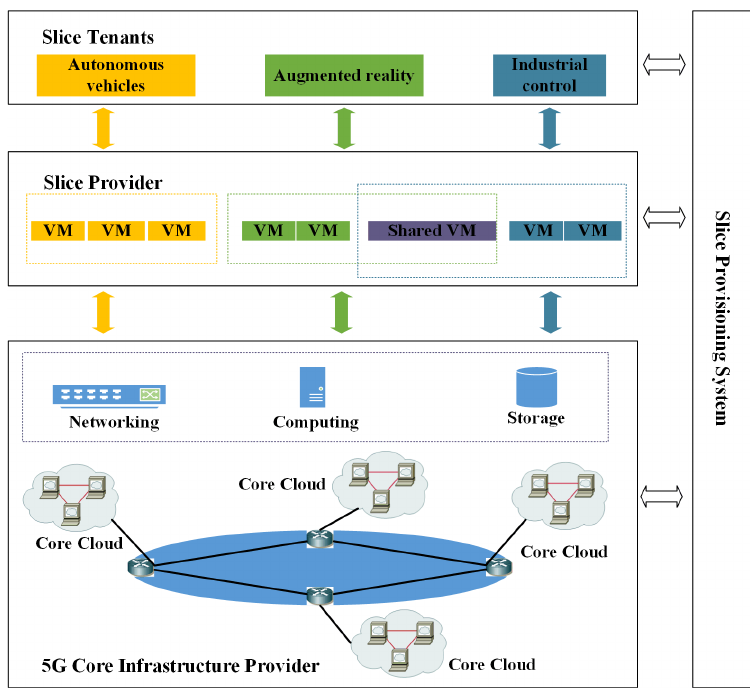
Figure 1. Illustration of three-layer 5G core network slicing system